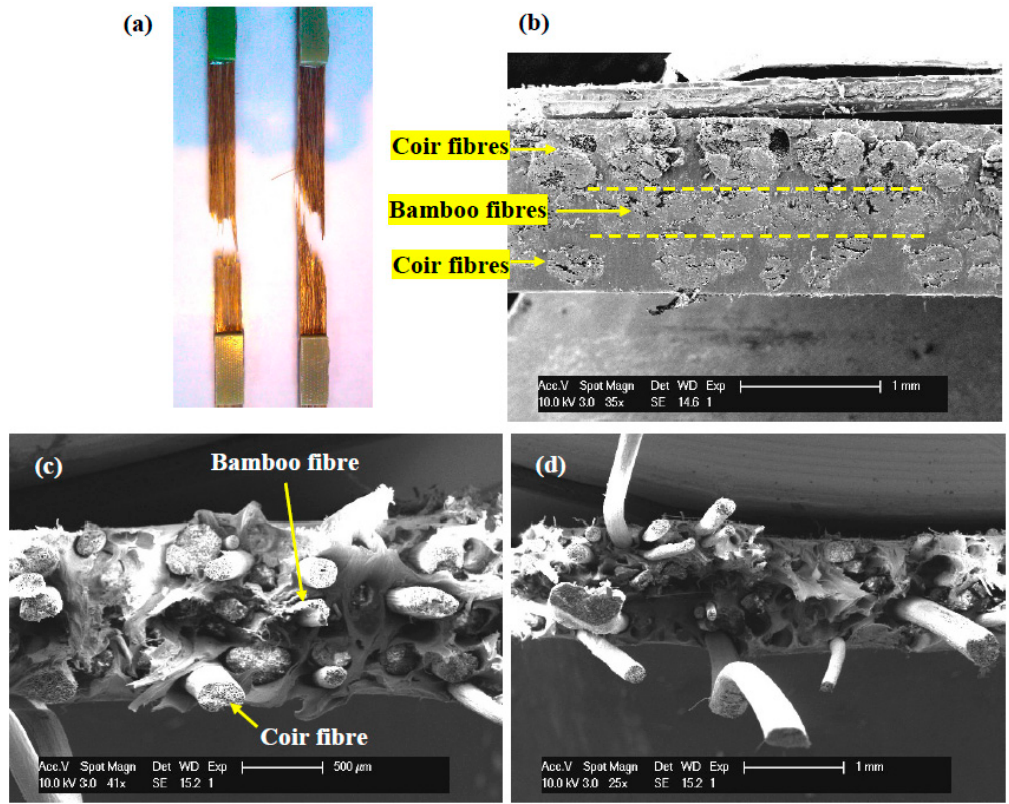
Figure 5. Fracture of the hybrid composite. ( a ) A typical sample fracture in tensile test; ( b ) a cross-section of the composite showing coir and bamboo fiber are distributed in three layers; ( c ) and ( d ) fracture surface of the composite in the tensile test.